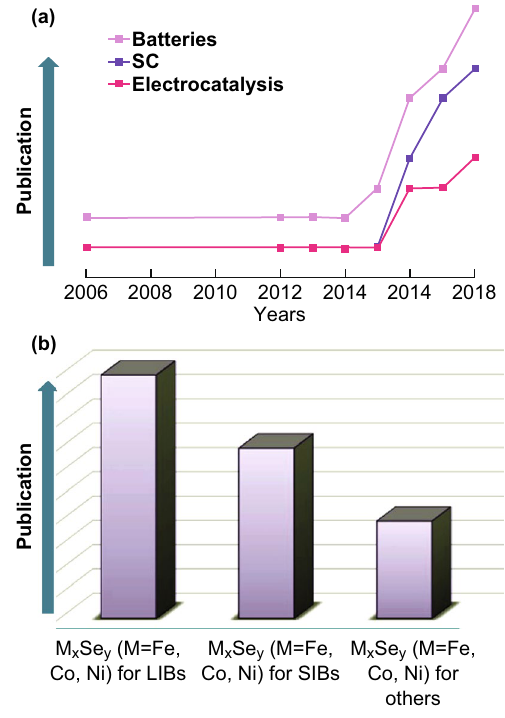
Fig. 1 a Research trends of transition-metal selenides in electro- chemical energy storage (batteries, SCs) and conversion (electrocatal- ysis) from 2006 to 2018. b Use of transition-metal selenides in vari- ous types of batteries (LIBs, SIBs, and other